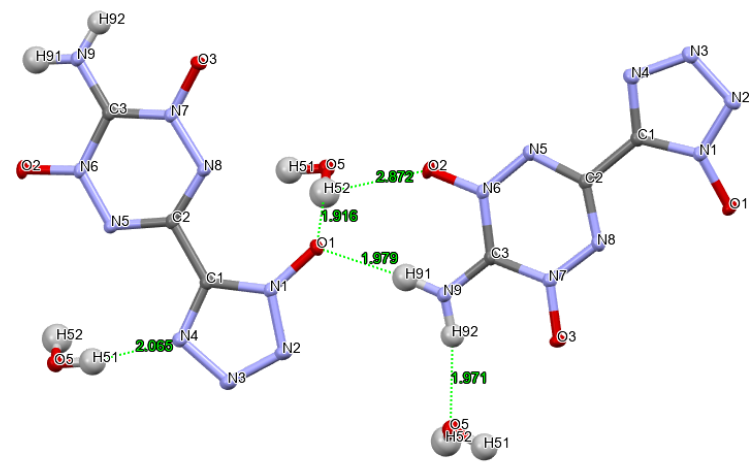
Figure 5. H-bonds formed by the hydroxytetrazole motif in the crystal of 11 . The values of the bond lengths are given in angstroms.